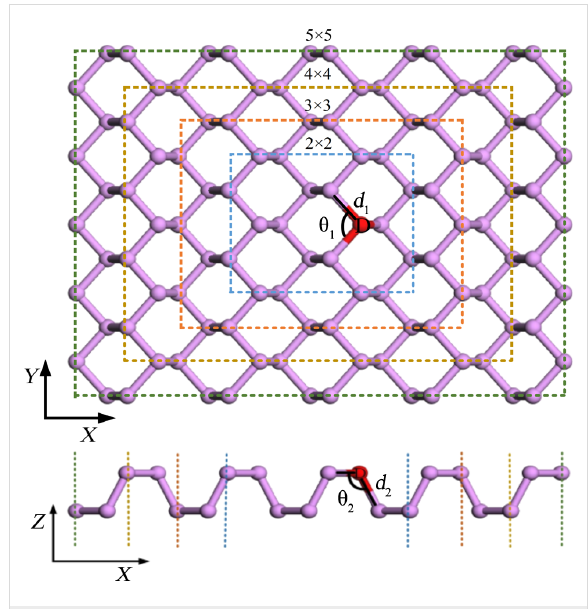
Figure 7: Top view and side view of the physical model of doped monolayer phosphorene.